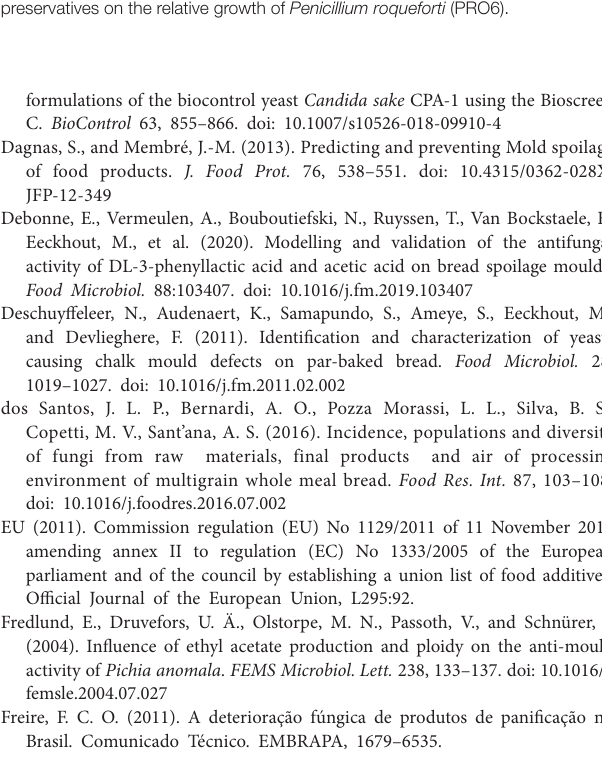
Supplementary Figure S1 | (A) Effect of Calcium propionate (CP) and Potassium sorbate (PS; 0; 32–128 mM) on relative growth (6 days) for Paecilomyces variotii (PV10) at 25 ° C and 30 ° C; (B) effect of these two preservatives on the relative growth of Penicillium roqueforti